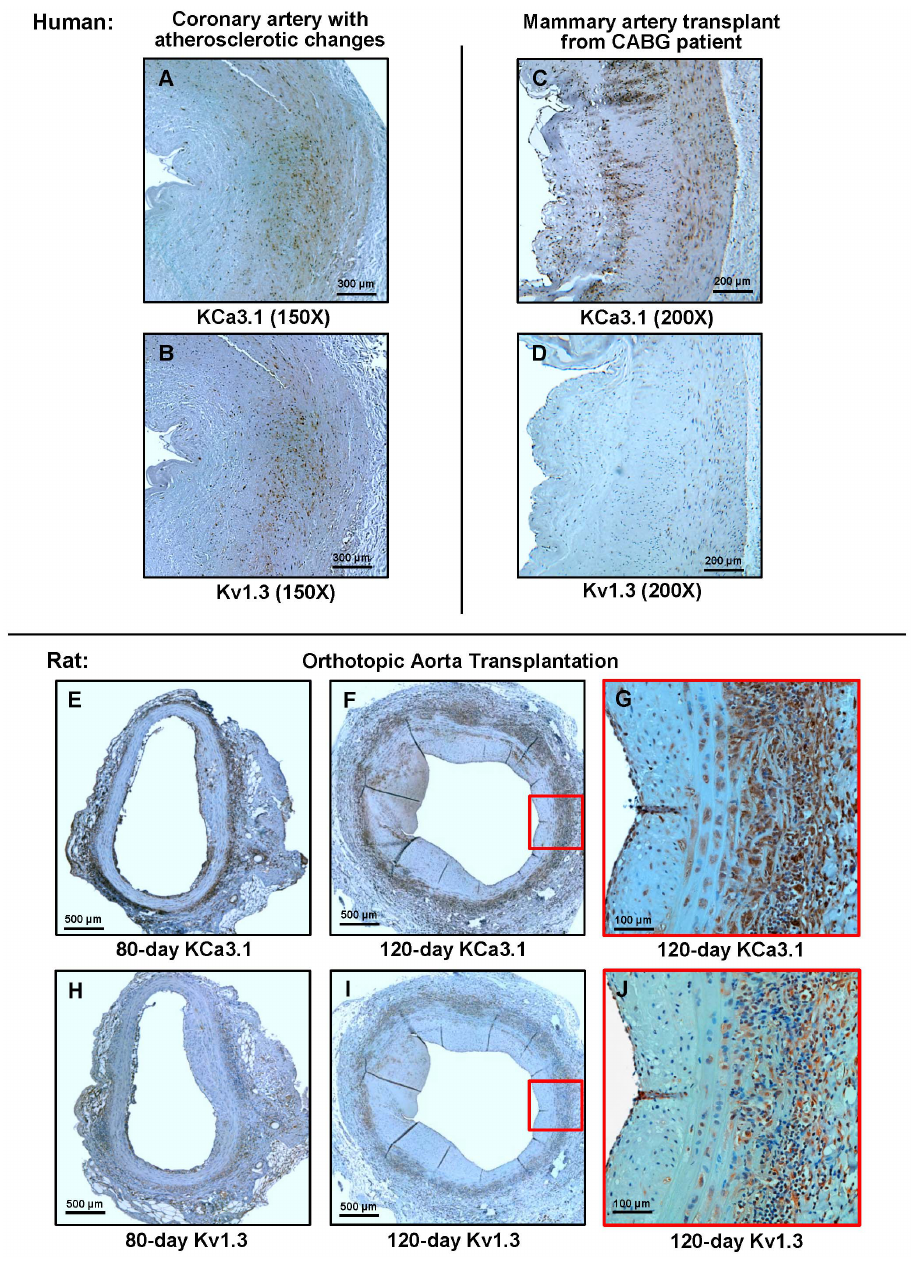
Figure 1. Kv1.3 and KCa3.1 expression in human and rat vasculopathy. (A, B) KCa3.1 and Kv1.3 staining in serial sections from a coronary artery with severe atherosclerotic changes. The vessel was harvested from the former heart of a patient receiving a heart transplant because of ischemic cardiomyopathy. (C, D) KCa3.1 and Kv1.3 staining in a mammary artery bypass graft. (E, F) KCa3.1 staining in orthotopic rat aorta transplants harvested 80 or 120 days after transplantation. G, Close-up of the boxed area in F. (H, I) Kv1.3 staining in serial sections of the grafts shown in E and F. (J) Close-up of the boxed area in F. Serial sections are 5 m m apart.